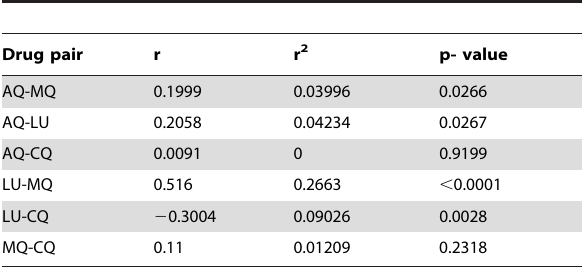
Table 2. Pearson product-moment correlation for CQ, AQ, MQ and LU.